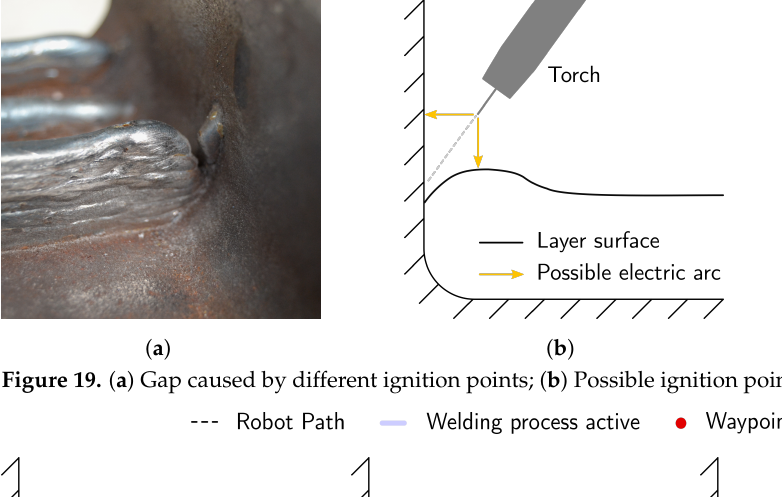
Figure 19. ( a ) Gap caused by different ignition points; ( b ) Possible ignition points.